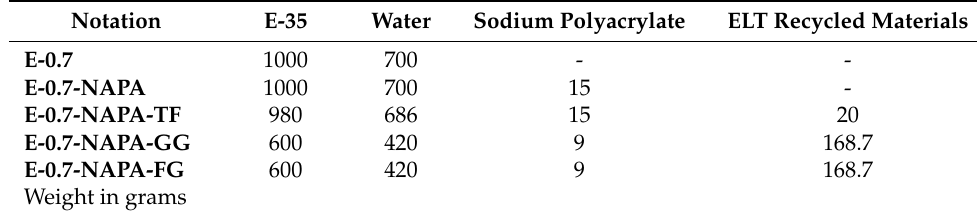
Table 2. Dosages composition of the different plaster